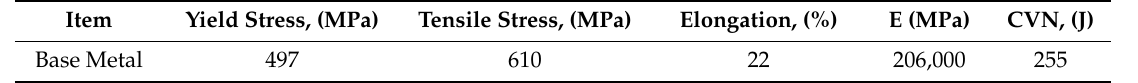
Table 2. Mechanical properties of the steel plate